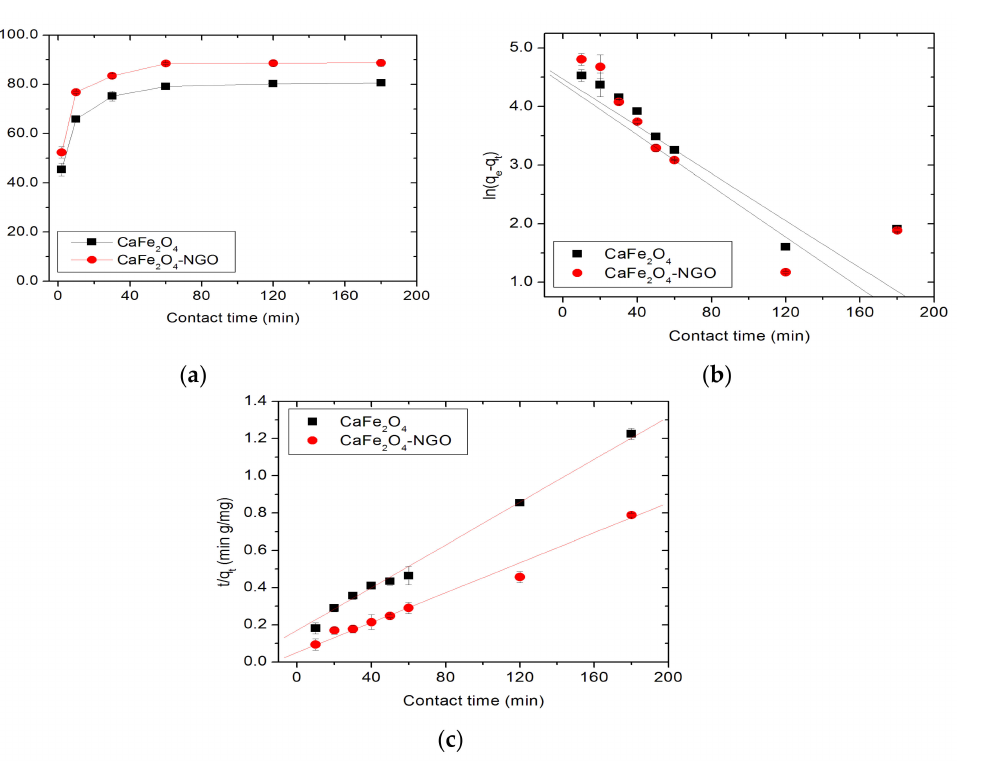
Figure 7. ( a ) Effect of contact time, ( b ) Pseudo-first-order model and ( c ) Pseudo-second-order model for adsorption of Pb(II). (Experimental conditions: pH, 6.0; contact time, 2.0 h; adsorbent dose, 0.01 g and Pb(II) concentration, 5.0